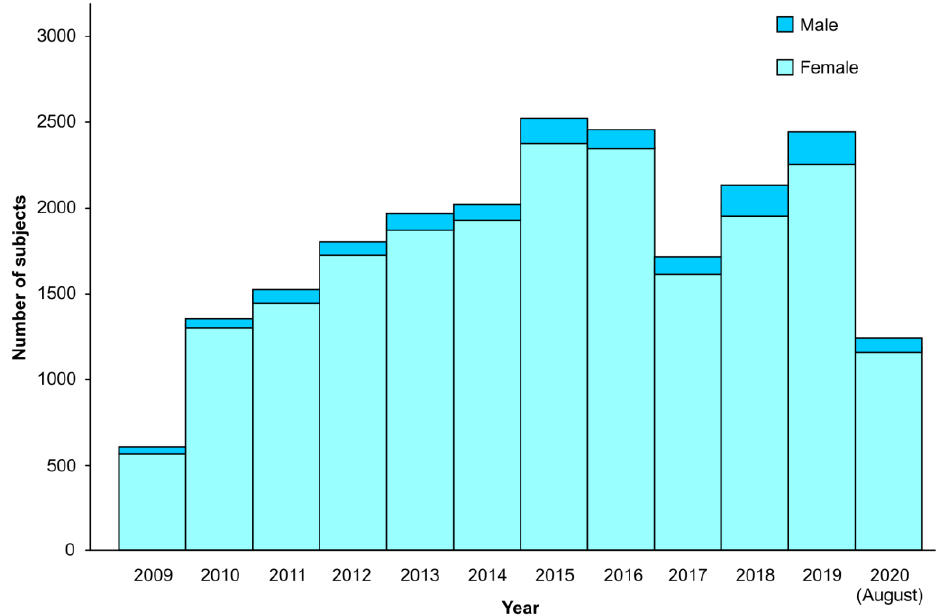
Figure 4. The total number of males and females with iron deficiency anemia cases from August